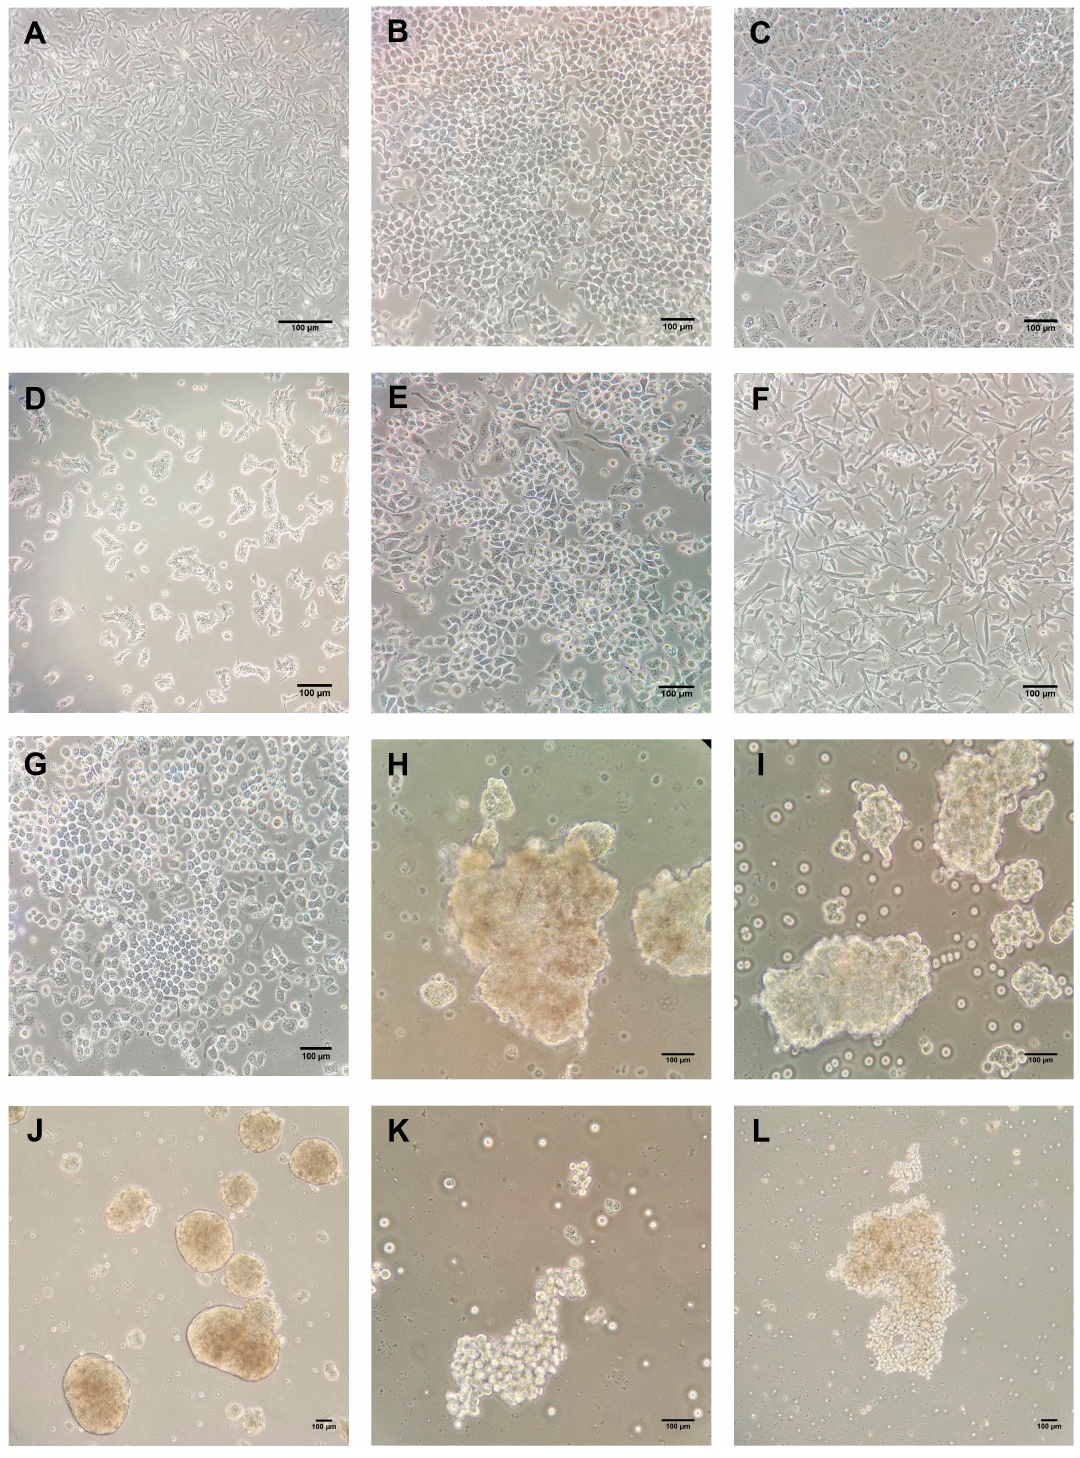
Figure 4. Breast epithelium (( A ): 184A1; 20×) and breast cancer cell lines (( B ): T-47D; 20×, ( C ): MCF-7; 20×, ( D ): BT-474; 20×, ( E ): SK-BR-3; 20× ( F ): MDA-MB-231; 20× and ( G ): MDA-MB-468; 20×). Mammospheres derived from breast cancer cell lines (( H ): T-47D; 20×, ( I ): MCF-7; 20×, ( J ): BT-474; 20×, ( K ): SK-BR-3; 20× and ( L ): MDA-MB-231; 20×). Scale bar: 100 μ m.